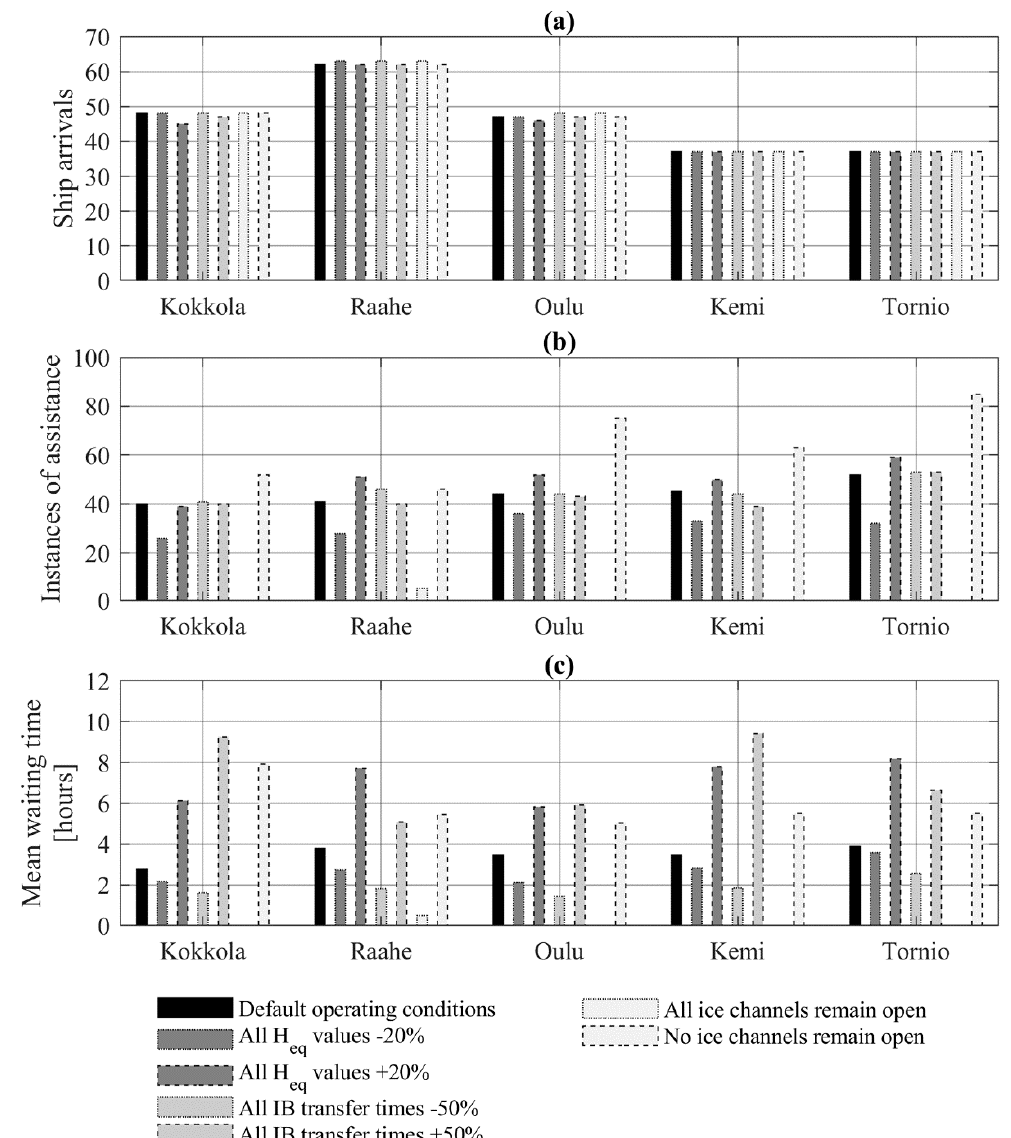
Figure 8. Sensitivity of the simulation output to changes in the underlying parameter values. ( a ) ship arrivals; ( b ) instances of IB assistance; ( c ) mean IB waiting times, the results were obtained by repeating the simulation so that one category of parameters was changed at a time, keeping all other parameter values constant.